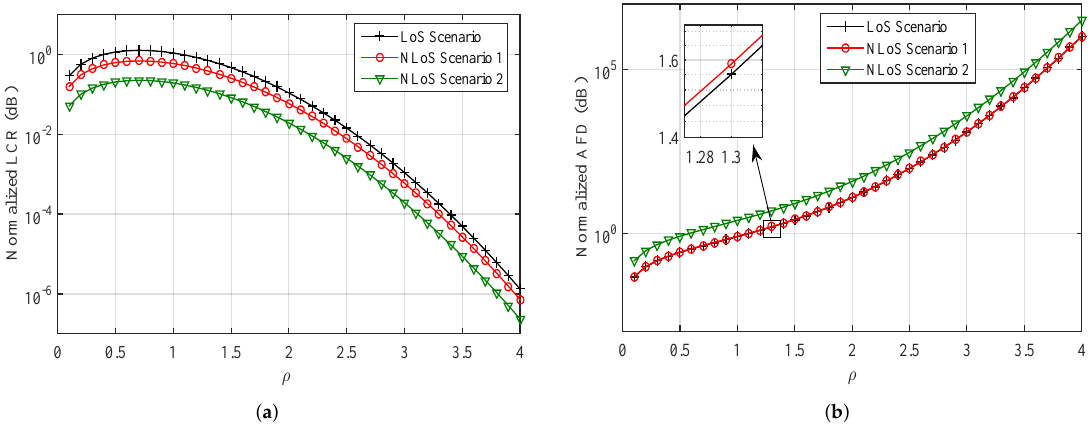
Figure 10. LCR and AFD plotted against different values of threshold levels in ( a , b ), respectively; for different scenarios of indoor mmWave (Case 3; 28 GHz) radio propagation environments. ( m = 4 for LoS Scenario and m = 1 for NLoS Scenarios, f d = 1 Hz).